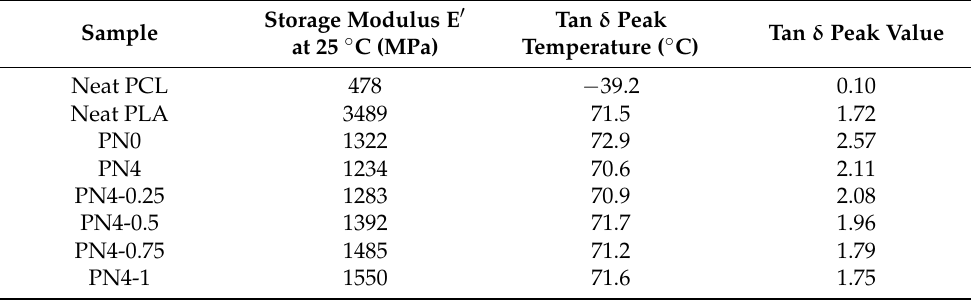
Table 5. DMA data of the PLA/PCL nanocomposites derived from the DMA